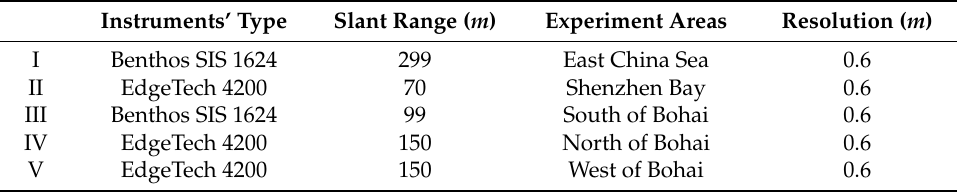
Table 10. The surveying areas and SSS instruments used for the